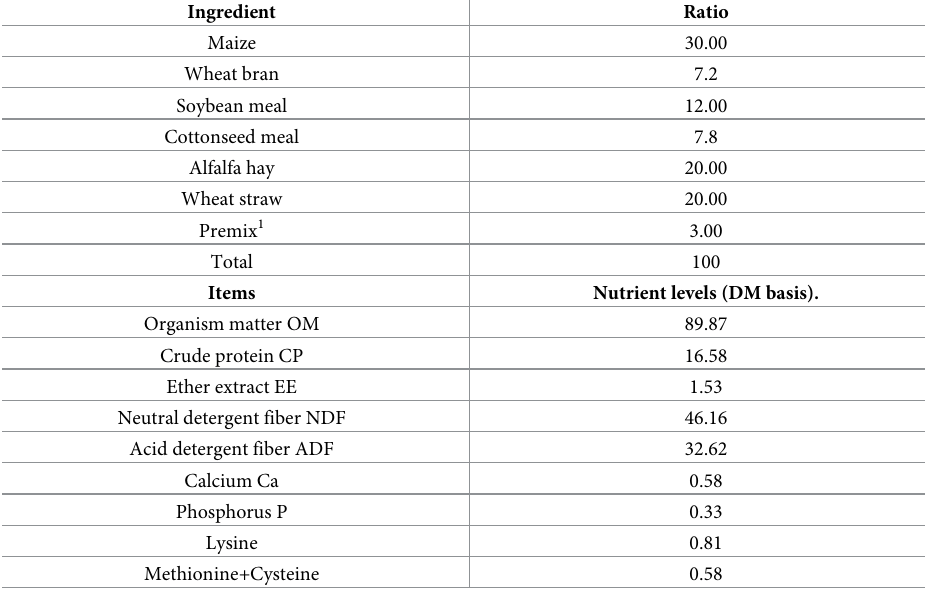
Table 1. Feed ingredients and nutrient levels of experimental diets (%). Ingredient Ratio